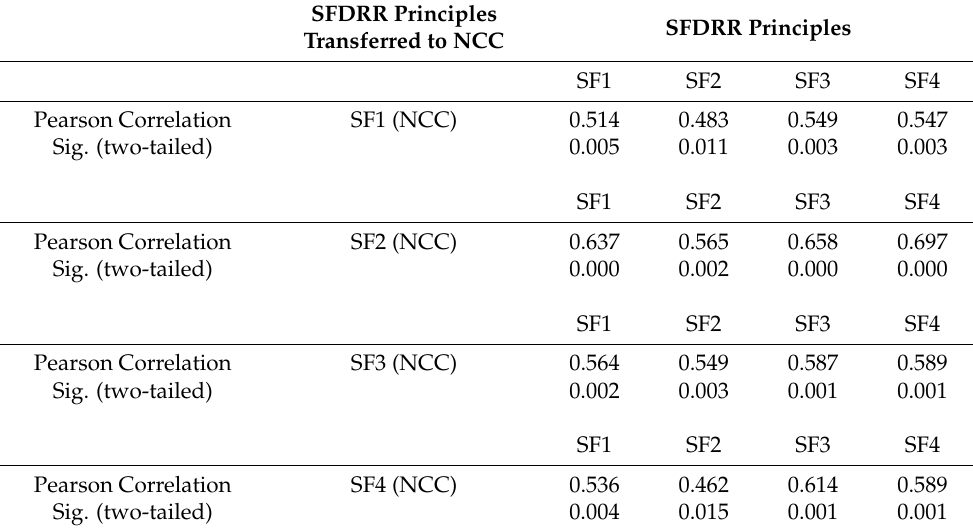
Table 5. Correlation analysis between NCC and